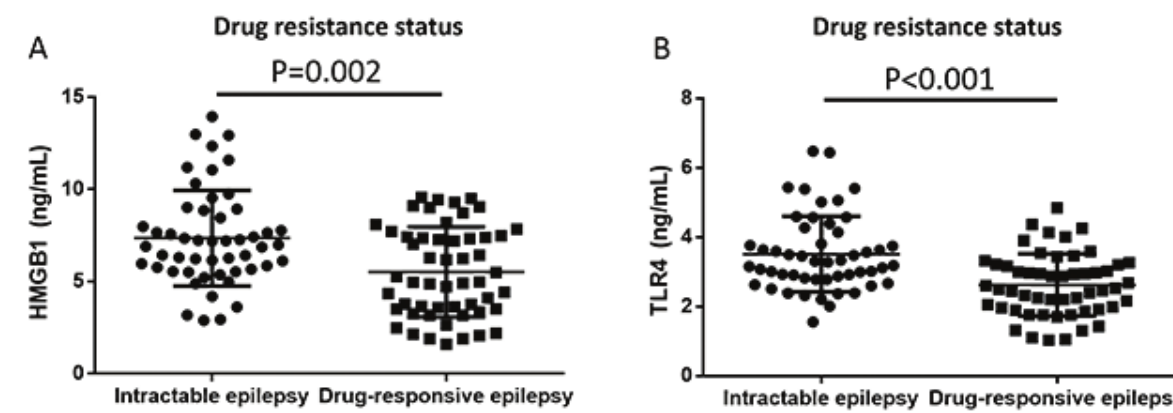
Figure 6. Comparison of HMGB1 ( A ) and TLR4 ( B ) based on drug resistance status using the Mann-Whitney test. TLR4: toll-like receptor 4; HMGB1: high-mobility group